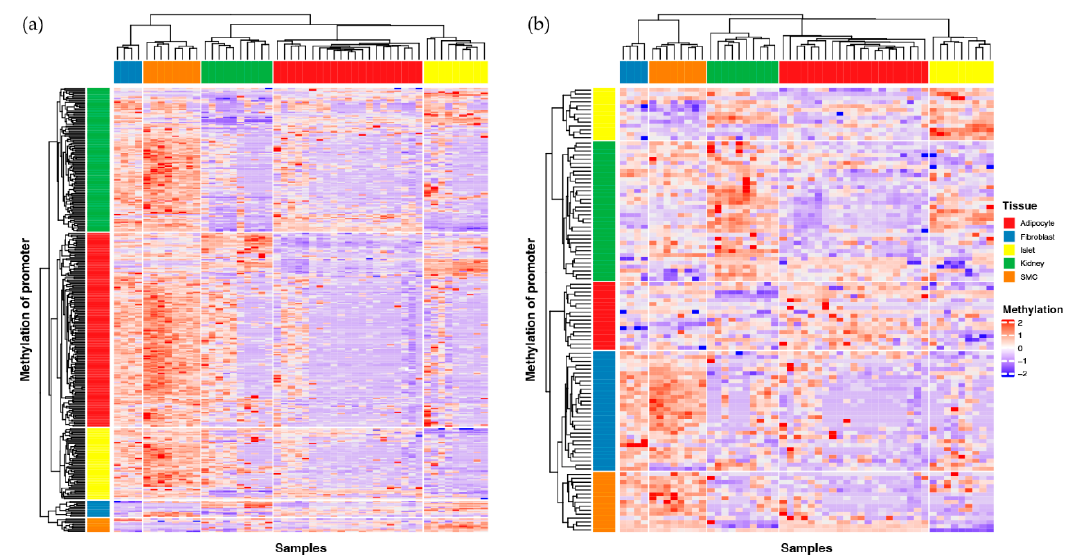
Figure 2. The proximal promoter methylation pattern according to the correlation between the gene expression and methylation levels. ( a ) The proximal promoter methylation patterns of 337 genes that were negatively correlated with gene expression ( τ > 0.8, Pearson’s correlation coefficient < − 0.3). ( b ) The proximal promoter methylation patterns of 112 genes that correlated positively with gene expression ( τ > 0.8, Pearson’s correlation coefficient > 0.3).